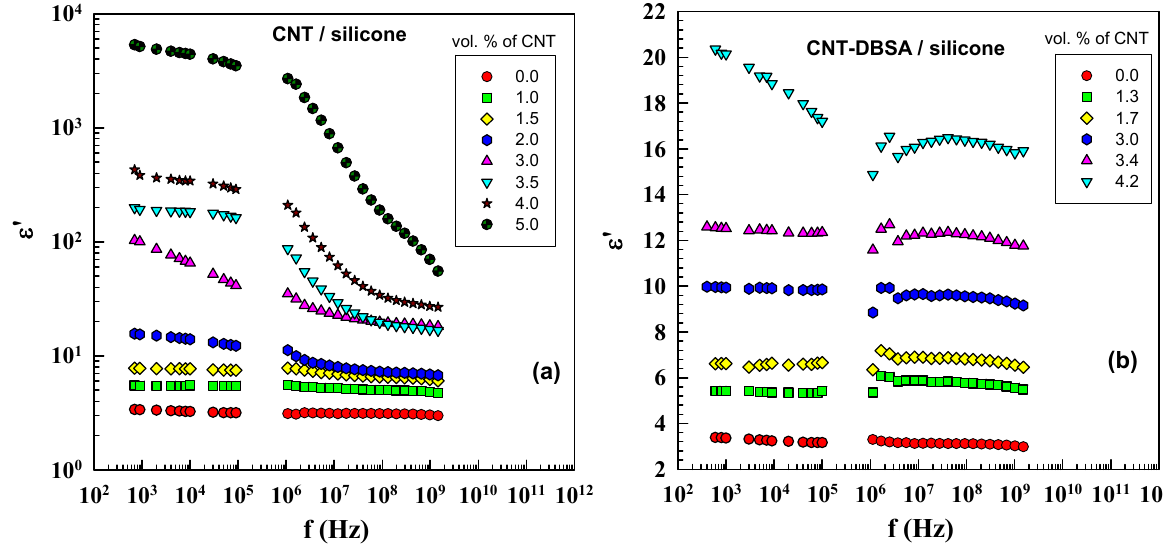
Figure 8. Real part of complex permittivity as a function of frequency for ( a ) CNT/silicone composites (mechanical mixing) and ( b ) CNT  DBSA/silicone composites (sonication) with various filler contents.